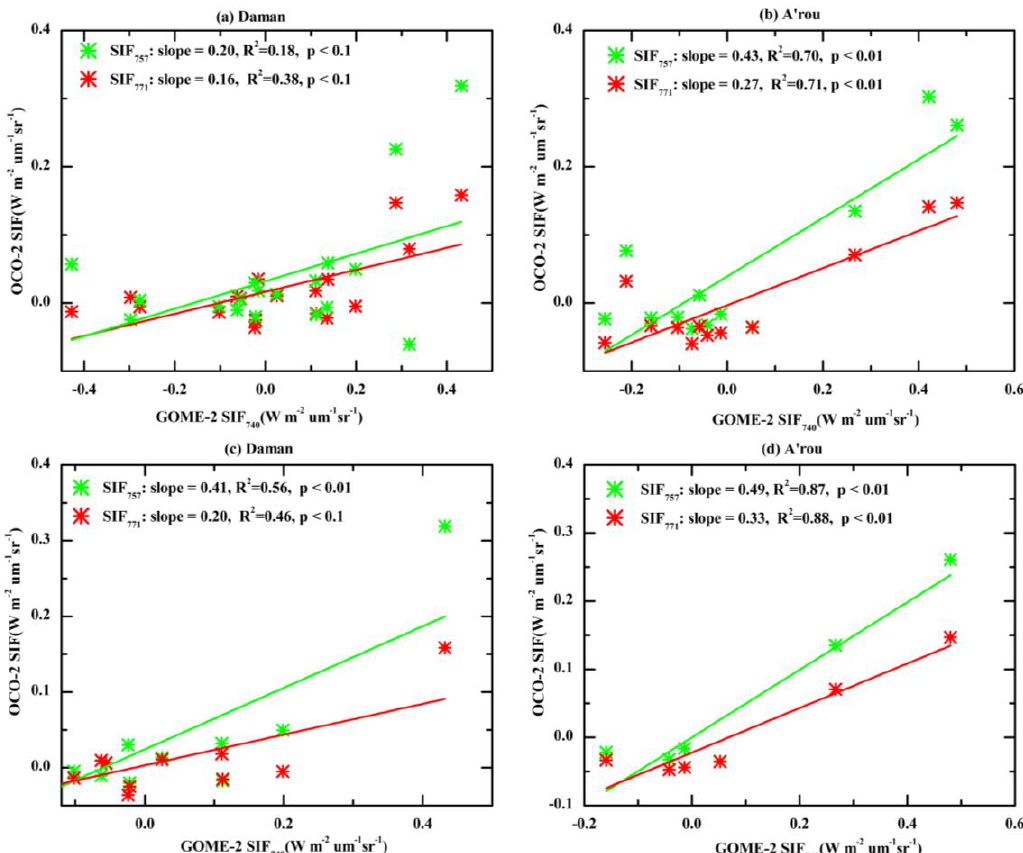
Figure 7. Relationships of the OCO-2 SIF with GOME-2 SIF within the overlaps of OCO-2 and GOME-2 SIF for 0.5° grid cells (i.e., the coordinates for each flux tower were taken as the center of the grid cell) at the Daman and A’rou sites. ( a ) And ( b ) relationships of OCO-2 SIF (i.e., all samples were averaged by using all soundings) with GOME-2 SIF. ( c ) And ( d ) relationships of OCO-2 SIF (i.e., the overlaps of certain samples with more than 70 soundings were selected) with GOME-2 SIF.